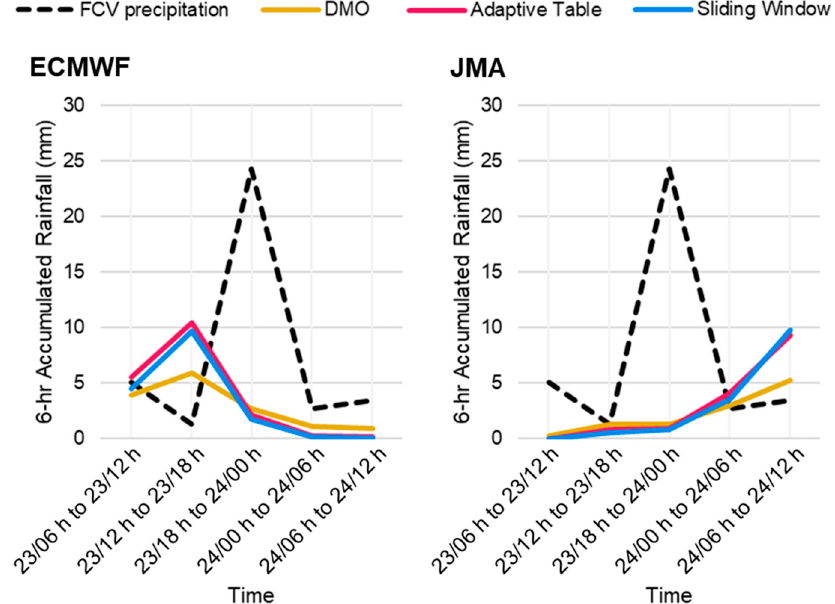
Figure 14. T + 12 6 h FCV rainfall (as the observed truth), the DMO rainfall of ECMWF/JMA and those with frequency-matching methods applied, for 23–24 July 2017.